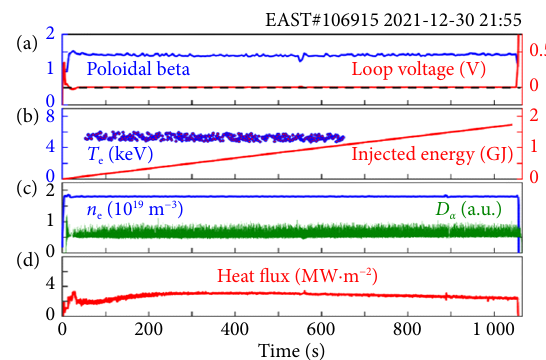
Fig. 2 The operation property of China’s EAST. ( a ) The poloidal beta and the loop voltage; ( b ) the electron temperature T e and injected energy; ( c ) the electron density n e and the recycled feature D α ; ( d ) the heat flux from plasma to